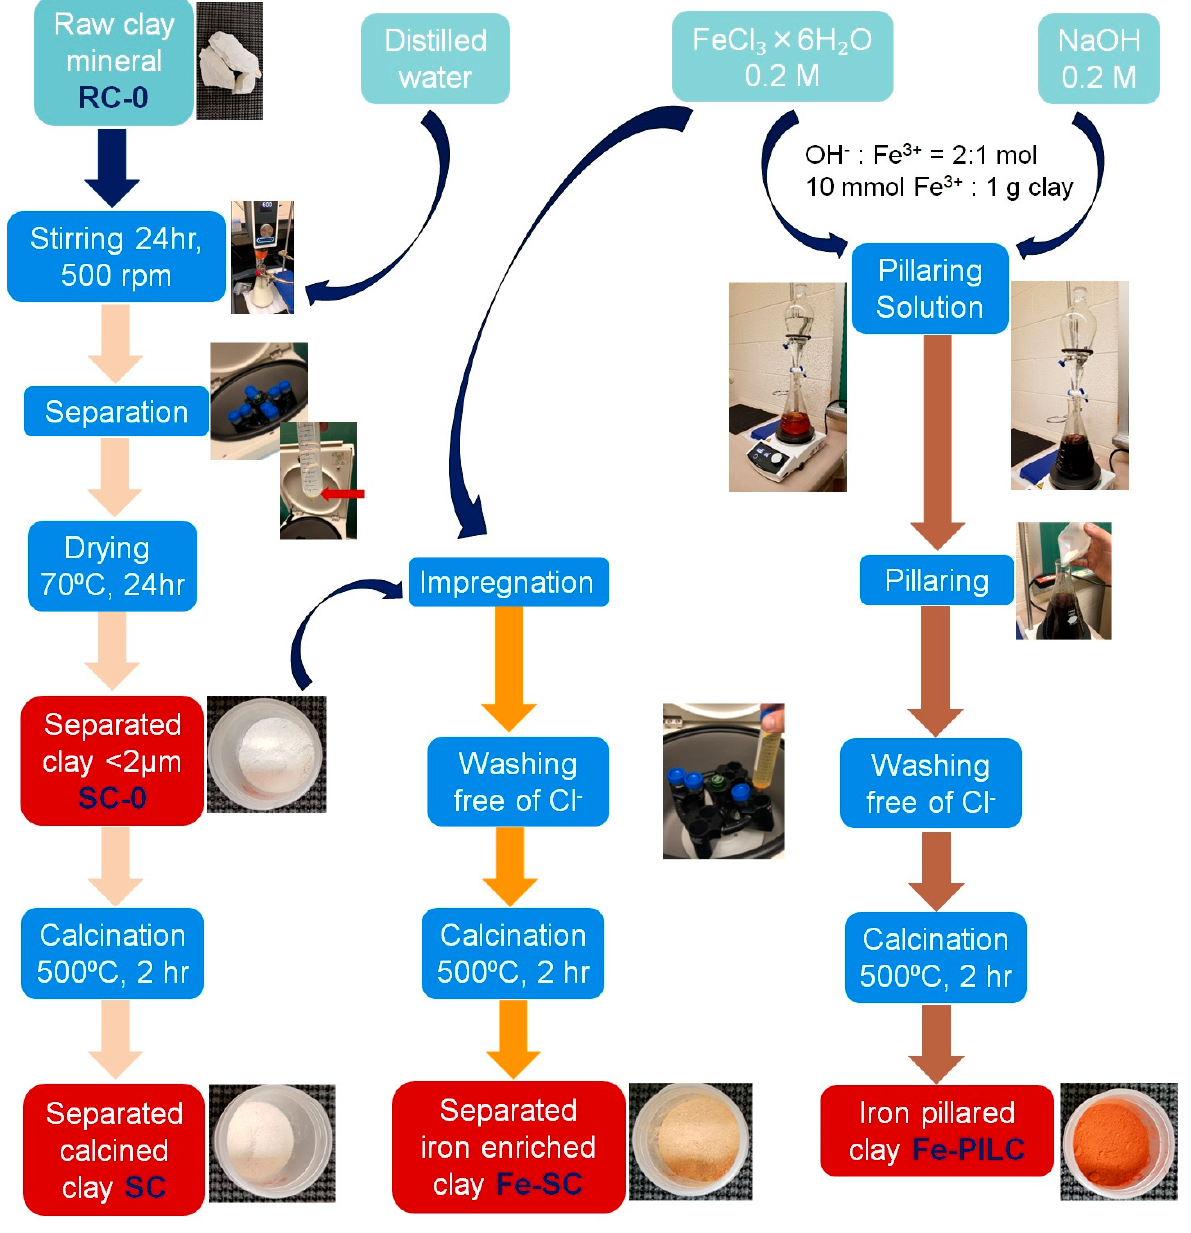
Figure 7. Flow diagram of the main steps involved in the synthesis of iron enriched clay samples.